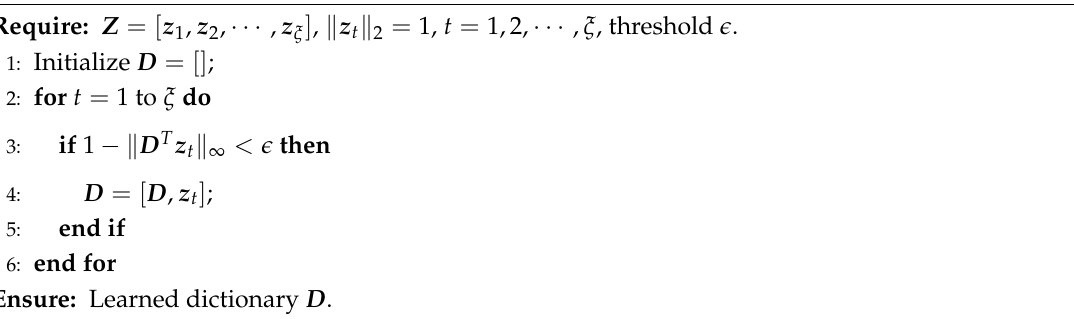
Algorithm 1 Proposed dictionary learning